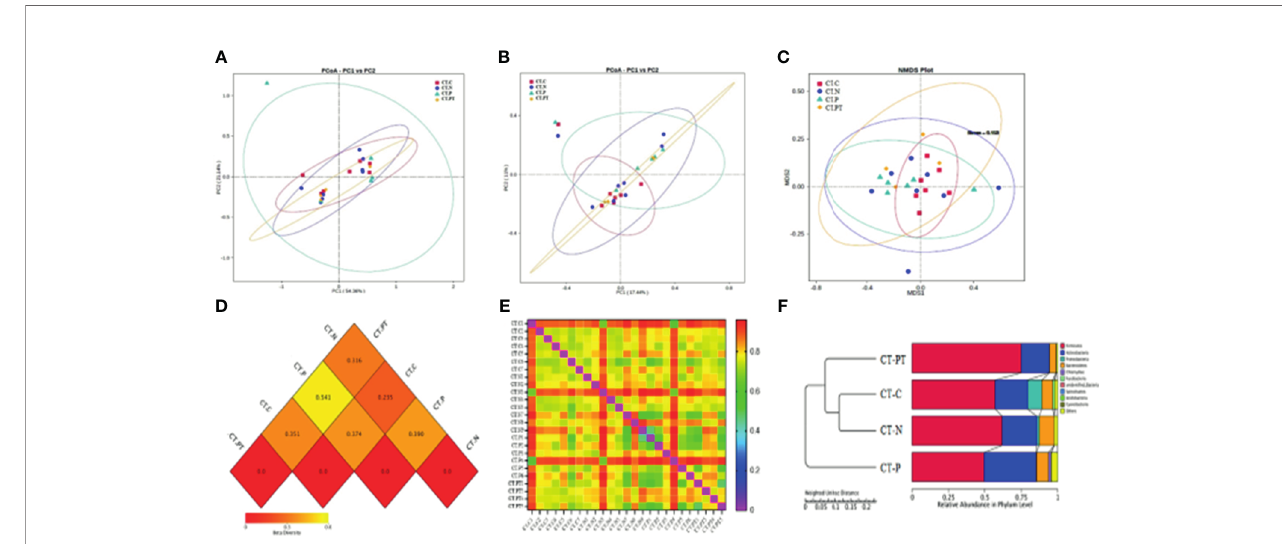
FIGURE 2 | Comparative analysis of beta diversity. Principal coordinate analysis (PCoA) based on weighted UniFrac (A) and unweighted Unifrac (B) distance. (C) Nonmetric multidimensional scaling analysis of each sample. Heatmap of beta-diversity index for each group (D) and samples (E) ; the legend below the heatmap represents each participant. (F) Unweighted pair group method with arithmetic mean (UPGMA) clustering tree of each group. CT-C, women from the physical examination center (PEC) who were healthy and C . trachomatis -negative; CT-N, women who were infertile and C . trachomatis -negative from the assisted reproductive technology center (ART); CT-P, women who were infertile and C. trachomatis -positive from the ART; CT-PT, CT-P women post-treatment with